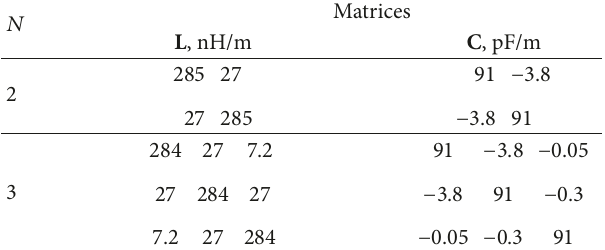
Table 1: The matrices of the